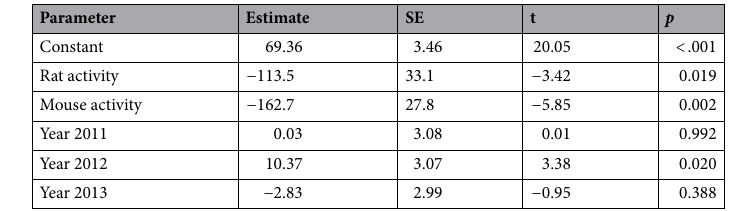
Table 4. Final model (chosen by stepwise regression) of the effect of late summer rat activity, mouse activity and year on Manx shearwater breeding success on the island of Rum 2010–2013. Data were modelled by General Linear